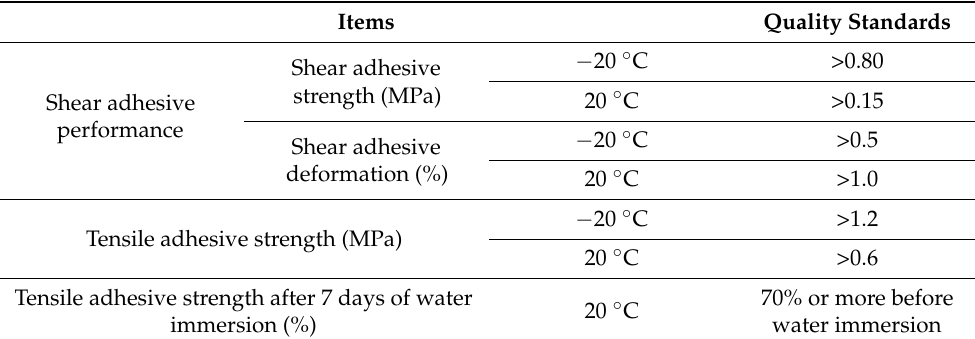
Table 6. Evaluation criteria and quality standards of waterproofing sheet.